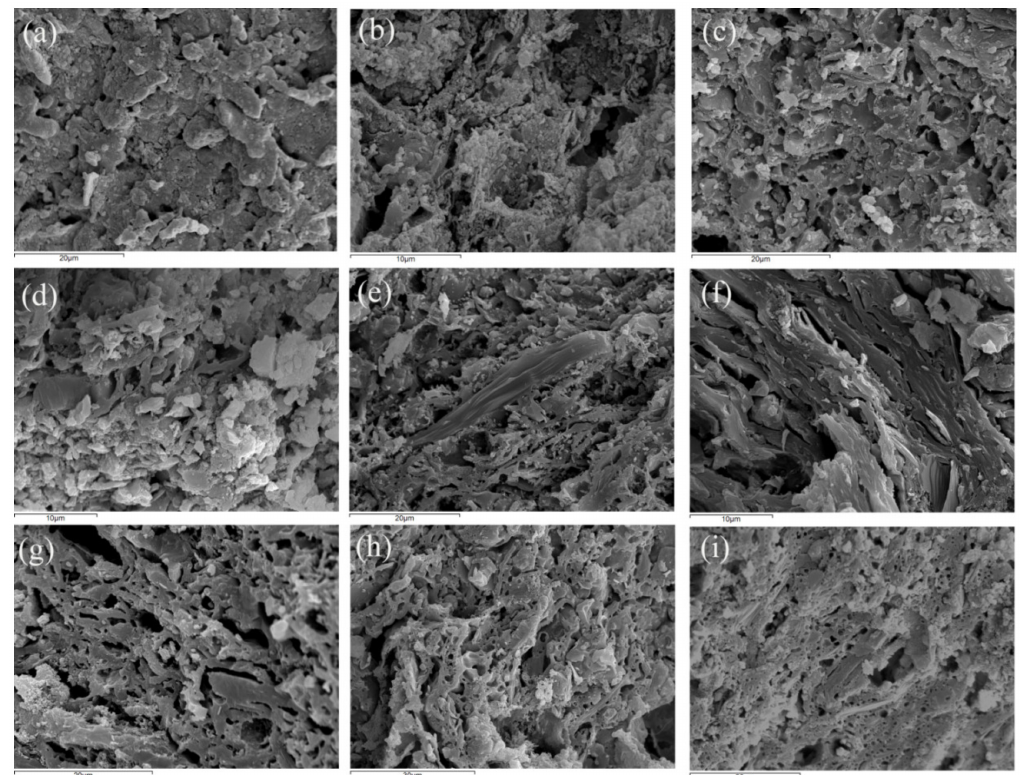
Figure 10. Secondary electron micrographs of fresh fractures from representative samples of the calcareous group: ( a ) K84,